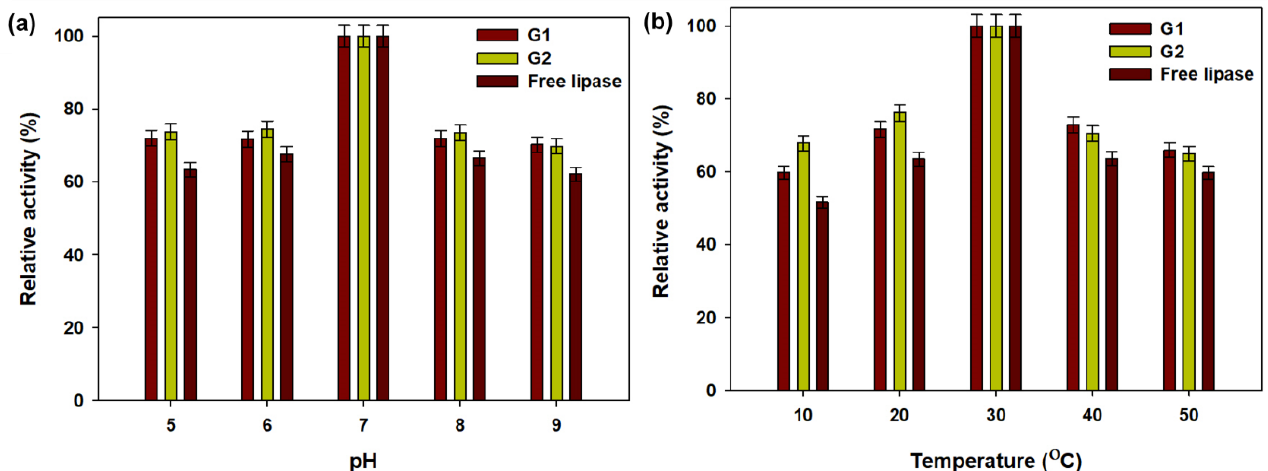
Figure 6. Effect of ( a ) pH and ( b ) temperature on the activity of native and immobilized lipase. All data are presented as the means ± standard deviation of three experiments.